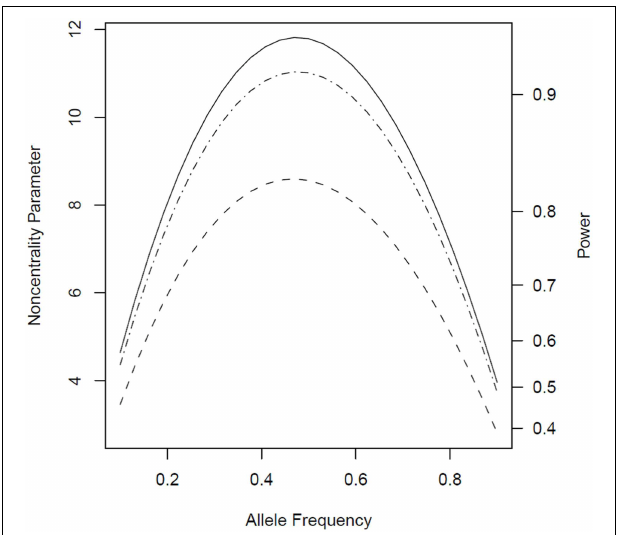
FIGURE 4 | Noncentrality parameter and power as a function of missing genotype rates. All designs used 300 triads from a homogeneous population with a range of missing genotype rates in the fathers. The risk scenario is: R 1 = R m 1 = 1 . 4 , R 2 = R m 2 = 1 . 96 , and S 1 = S 2 = 1 . The baseline risk in mothers of affected offspring is 0.2. Allele frequency was set at 0.3. Vertical axes: left, the chi-squared noncentrality parameter for a 1-df likelihood ratio test; right, power at α = 0 . 05 . Horizontal axis shows the missing genotype rates in the fathers ranging from 0 to 1. Curves: dash, combTDT ; dash-dot, PPI-LRT ; solid, PPI-LRT test in the absence of missing genotypes which serves as a reference to show the impact of missing genotypes.